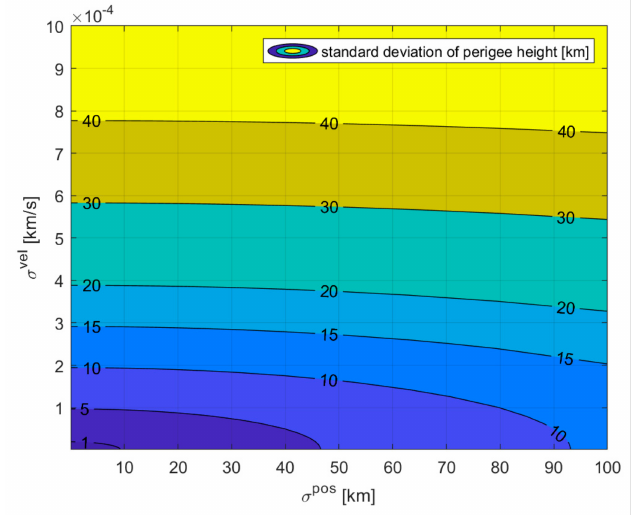
Figure 5. The impacts of different σ pos and σ vel on the perigee height standard